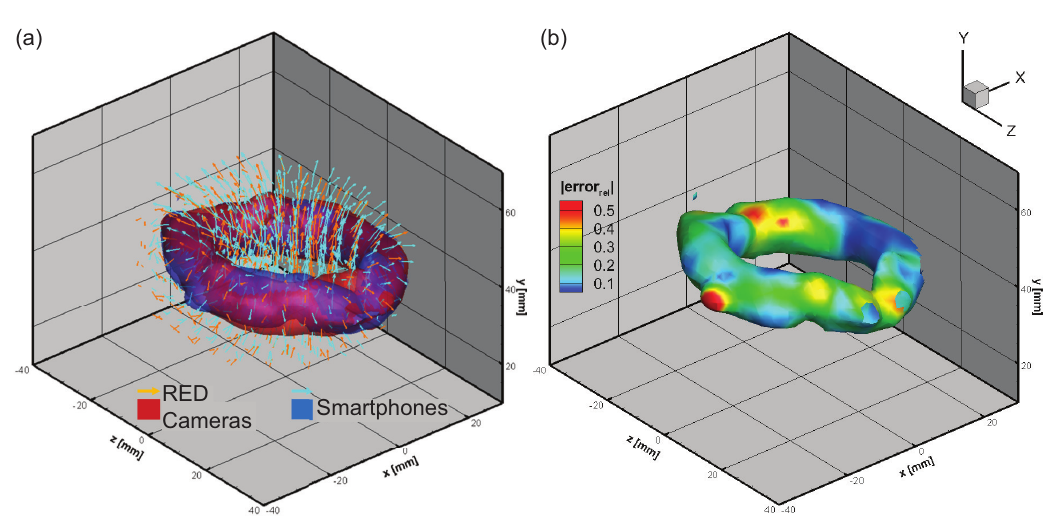
Figure 10. ( a ) Overlay of an isovorticity surface, | ω | = 210 s − 1 , and velocity vectors from both systems, the smartphone system result is presented as a blue surface and cyan velocity vectors while the RED camera system results are presented as a red surface and orange velocity vectors. Only every sixth velocity vector is shown. One can visually notice both results overlap and are very similar qualitatively. ( b ) The contours of the relative error shown on the isovorticity surface of magnitude | ω | = 210 s − 1 These regions represent an upper bound of the error due to the large velocity gradients present in this region of the